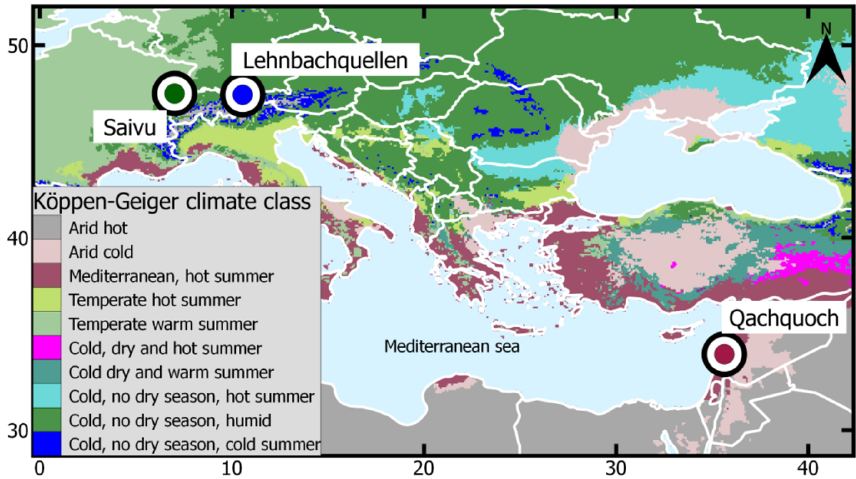
Figure 2. Map showing locations of the three test springs obtained from the WoKaS database and different Köppen–Geiger hydroclimatic classes. Table 3. Summary of test spring site properties and characteristics of spring discharge hydrographs. Properties Climate description